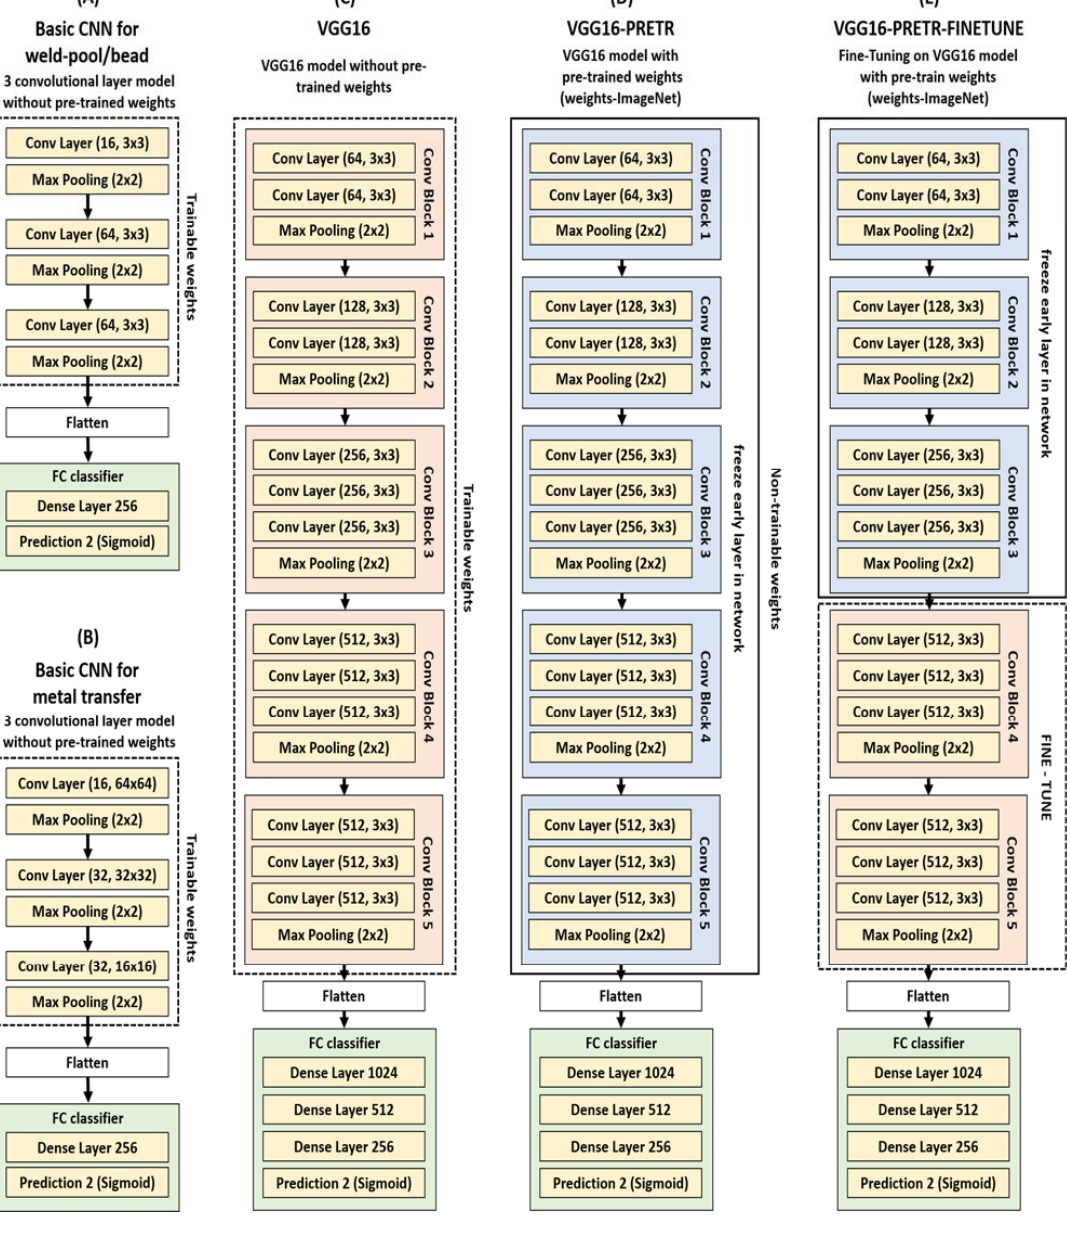
Figure 7. Tested CNN architectures for AI development.